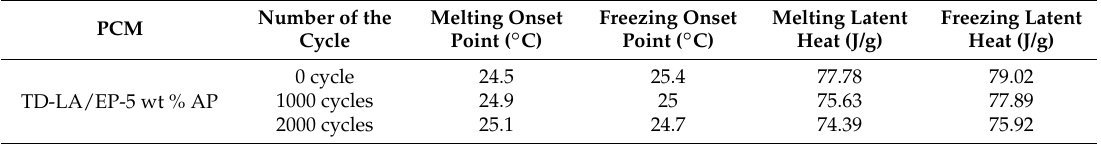
Figure 12. DSC curves of TD-LA/EP-AP after thermal cycling. Table 8. Comparison of heat storage parameters of TD-LA/EP-AP before and after 1000 and 2000 cycles.